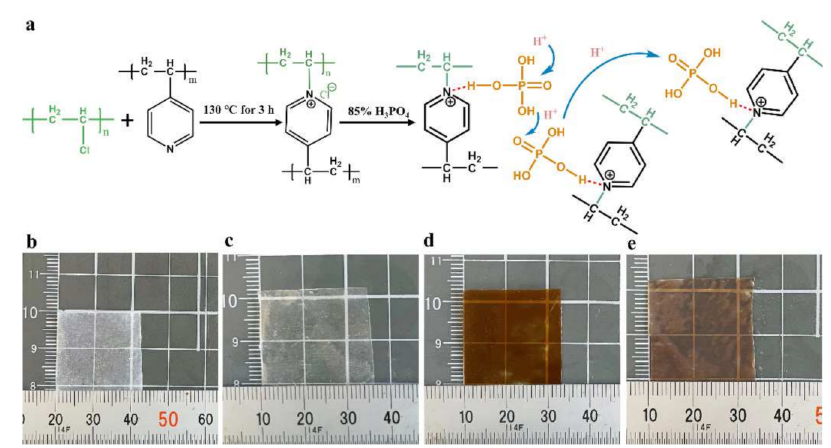
Figure 1. ( a ) Schematic of the preparation of PVC-P4VP/PA membrane through cross-linking reaction and the optical images of PVC ( b ), P4VP ( c ), PVC-P4VP ( d ) and PVC-P4VP/PA ( e )